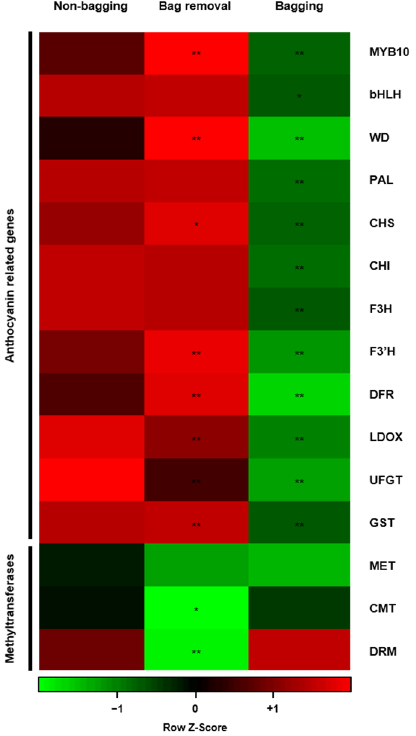
Figure 7. Heat map analysis for expression levels of anthocyanin- and methylation-related genes in mature ‘Fuji’ apples cultivated under different bag treatments: no bagging (control; labeled as “non-bagging”), bagging followed by bag removal (labeled as “bag removal”), and bagging with no bag removal (labeled as “bagging”). The color scale at the bottom shows a log 2 -transformed gene expression level from − 1 (green), through 0 (black), to +1 (red) that represents low, intermediate, and high expression levels. * and ** indicate significance levels of p < 0.05 and p < 0.01,